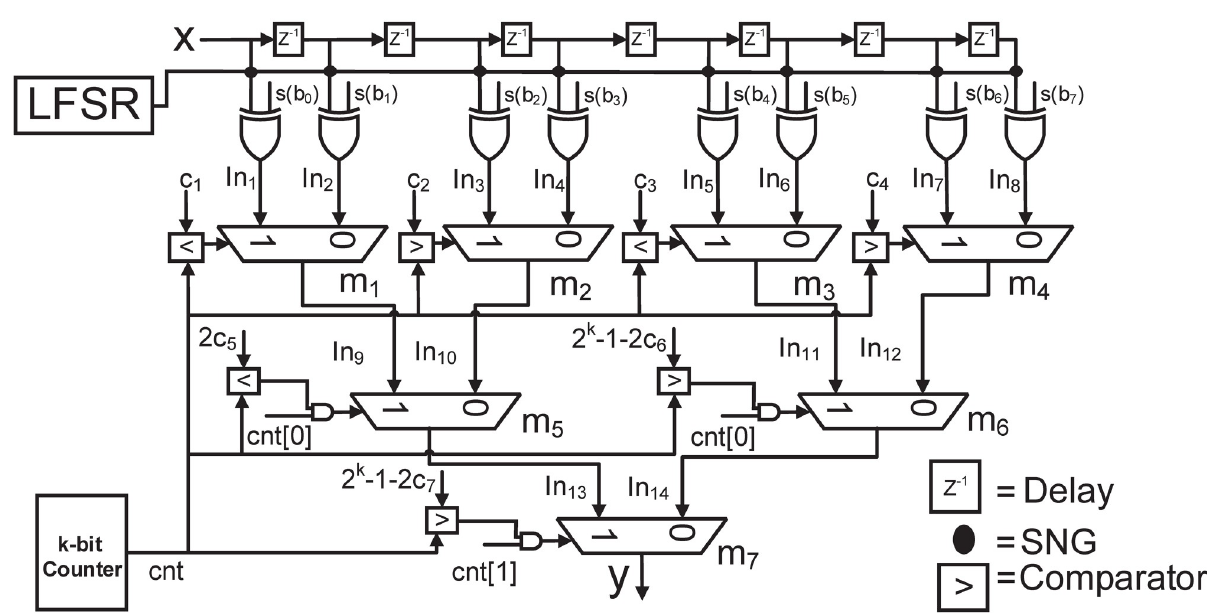
Fig 7. Proposed architecture for 7 th order FIR